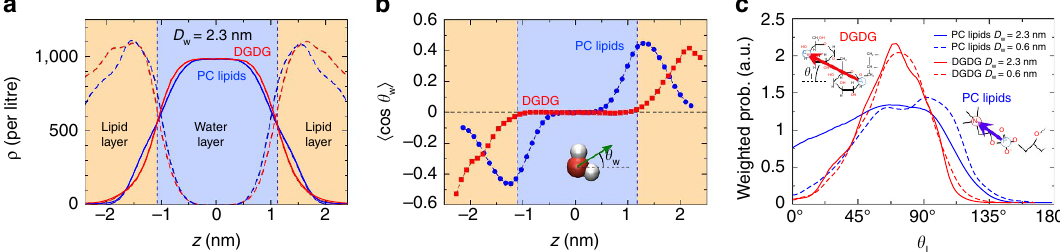
Figure 4 | Hydrogen bonds. ( a ) Total number of HBs per DGDG lipid as a function of the membrane separation. The dashed line indicates an exponential fit with decay length l ¼ 0.12nm. Inset: ll, lw and ww HBs. In the plot, ww refers to the excess HB number with respect to bulk water, n HB text. Dashed lines indicate exponential fits with the same decay length l ¼ 0.26 ± 0.01nm for all three curves. ( b ) The total number of HBs versus the interaction free energy for DGDG. Dashed line: Linear regression through all data points. ( c ) The same plot for PC lipids. Shaded region: High hydration limit E 0. The error bars in all three panels represent 1 s.d. of uncertainty. where D n HB tot